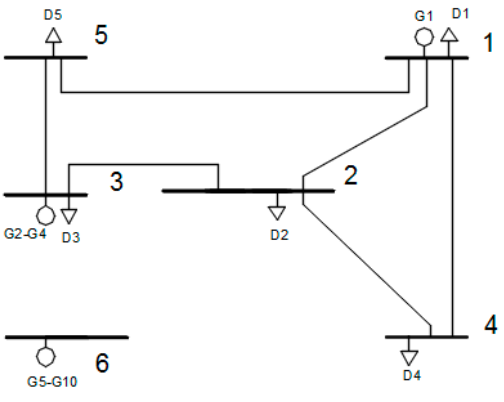
Figure 2. Garver system 6 nodes unmodified.